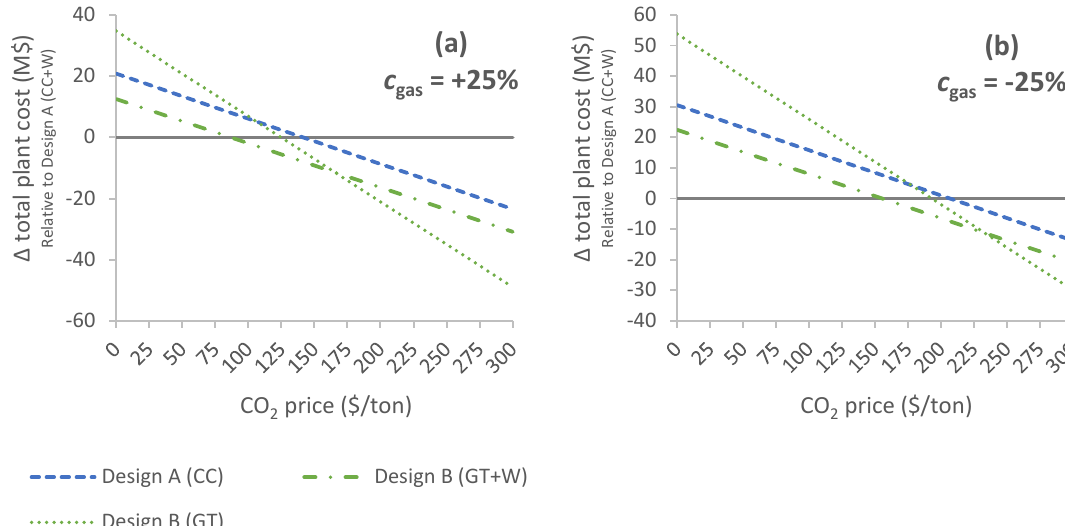
Figure 15. Variation of the total plant cost of Design A (CC), Design B (GT+W) and Design B (GT) relative to Design A (CC+W), as a function of the CO 2 price, when the gas price is increased by ( a ) +25% or decreased by ( b ) 25%.